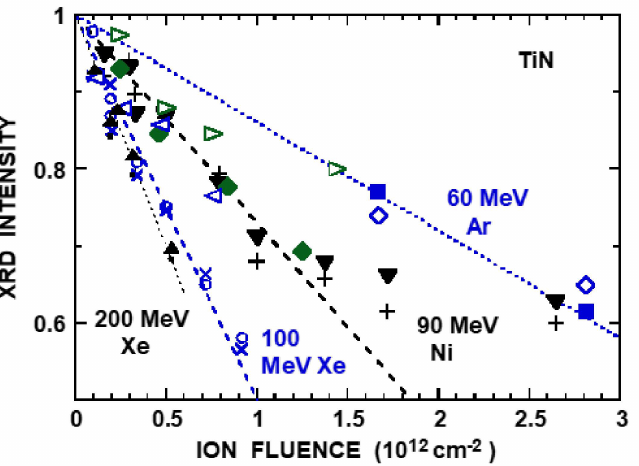
Figure 8. XRD intensity normalized to unirradiated films of TiN as a function of ion fluence for 60 MeV Ar ( (cid:4) , ♦ ), 90 MeV Ni ( (cid:72) , +, (cid:7) , (cid:84) ), 100 MeV Xe (o, x, Diffraction plane (111) at diffraction angle of ~36.6 ◦ is indicated by (cid:4) , (cid:72) , o and (cid:78) for SiO 2 substrate, (200) at ~43 ◦ by ♦ , +, x and • for SiO 2 substrate, (111) by (cid:7) for C-Al 2 O 3 substrate and (220) at ~61 ◦ by (cid:84) and for R-Al 2 O 3 substrate. Linear fit is indicated by dotted lines. An estimated error of XRD (cid:1) intensity is